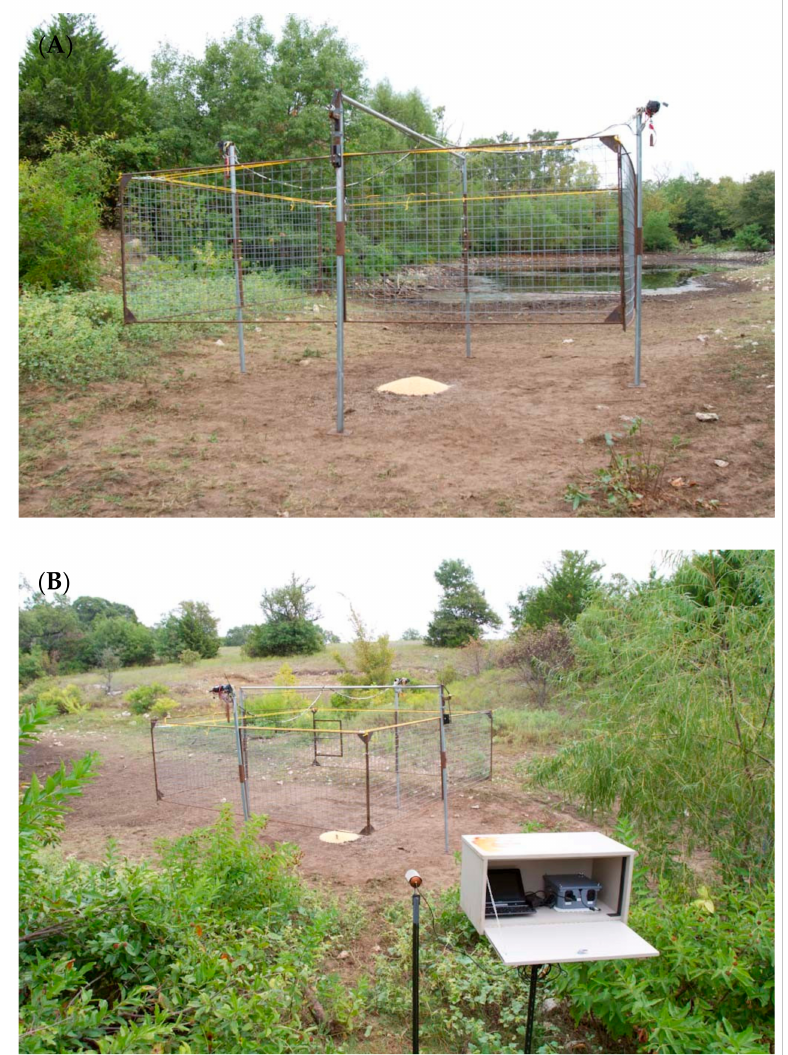
Figure 7. Suspended trap used to capture wild pigs ( Sus scrofa ) on Coffey, Oswalt Road and Red River ranches, Love County, OK, USA ( A ). Electronics, camera and hardware (in foreground) used to provide images of animals under the trap to the user via internet using cellular data ( B ). The trapper also used this system of hardware and software to send a signal for the trap to drop. Photographs courtesy of Noble Research Institute, LLC (Ardmore, OK,